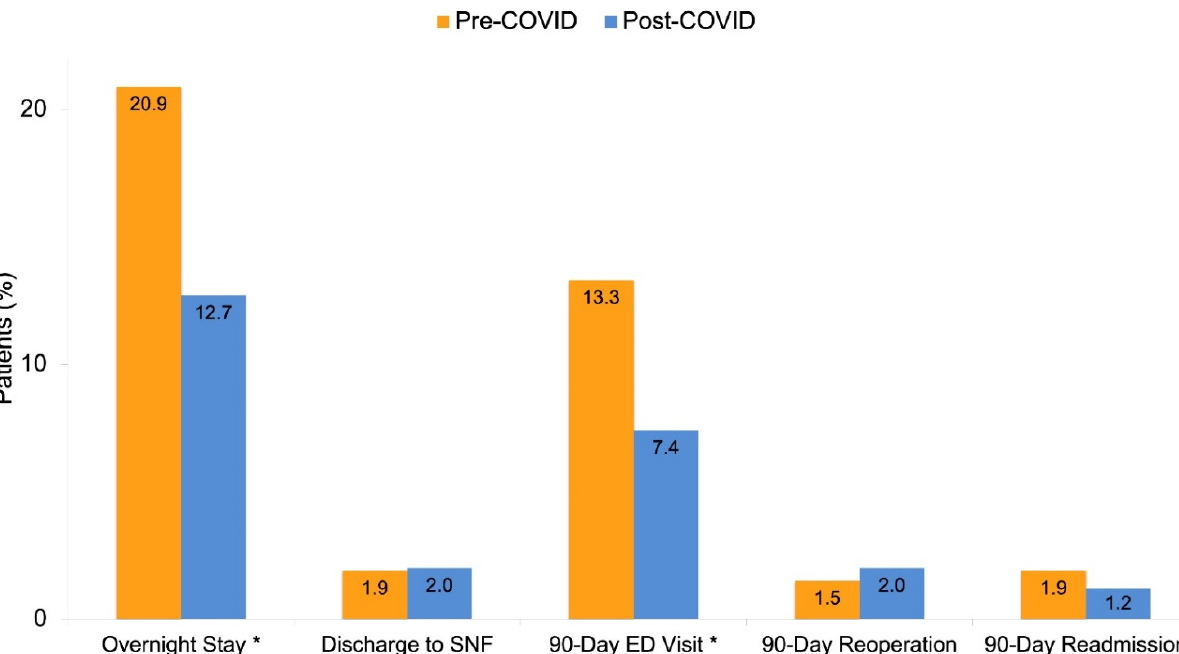
Figure 2. Rate of shoulder arthroplasties requiring overnight hospital stays over time. 4. Discussion The COVID-19 outbreak upended traditional health system practices amid an envi- ronment that demanded an accelerated pace of innovation. Health systems were faced with difficult decisions as to how to safely resume margin-producing elective orthopedic surgery in the midst of the pandemic. Many have suggested transitioning more joint ar- throplasty procedures to the outpatient setting [4,9,10], but whether this actually has taken